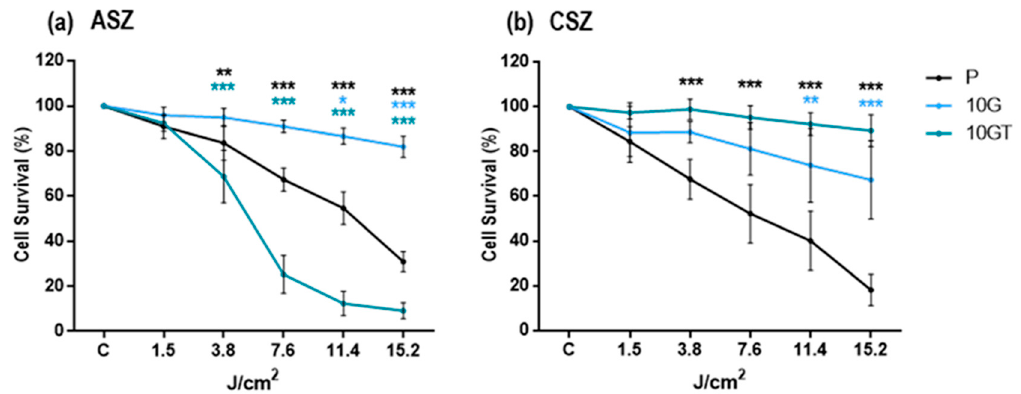
Figure 1. Cell survival after Photodynamic Therapy (PDT): Survival of P, 10 G, and 10 GT populations of ( a ) ASZ and ( b ) CSZ cell lines subjected to methyl-aminolevulinate (MAL)-PDT and evaluated by the 3-[4,5-dimethylthiazol-2-yl]-2,5- diphenyltetrazoliumbromide (MTT assay). MTT test was performed 24 h after PDT treatment (0.2 mM MAL for 5 h and subsequently exposed to variable doses of red light). The 10 G population showed the highest resistance to treatment in ASZ cell lines, whereas in CSZ, it was the 10 GT population. Values were represented as mean ± SD (* p < 0.05; ** p < 0.01; *** p < 0.001) ( n = 5).